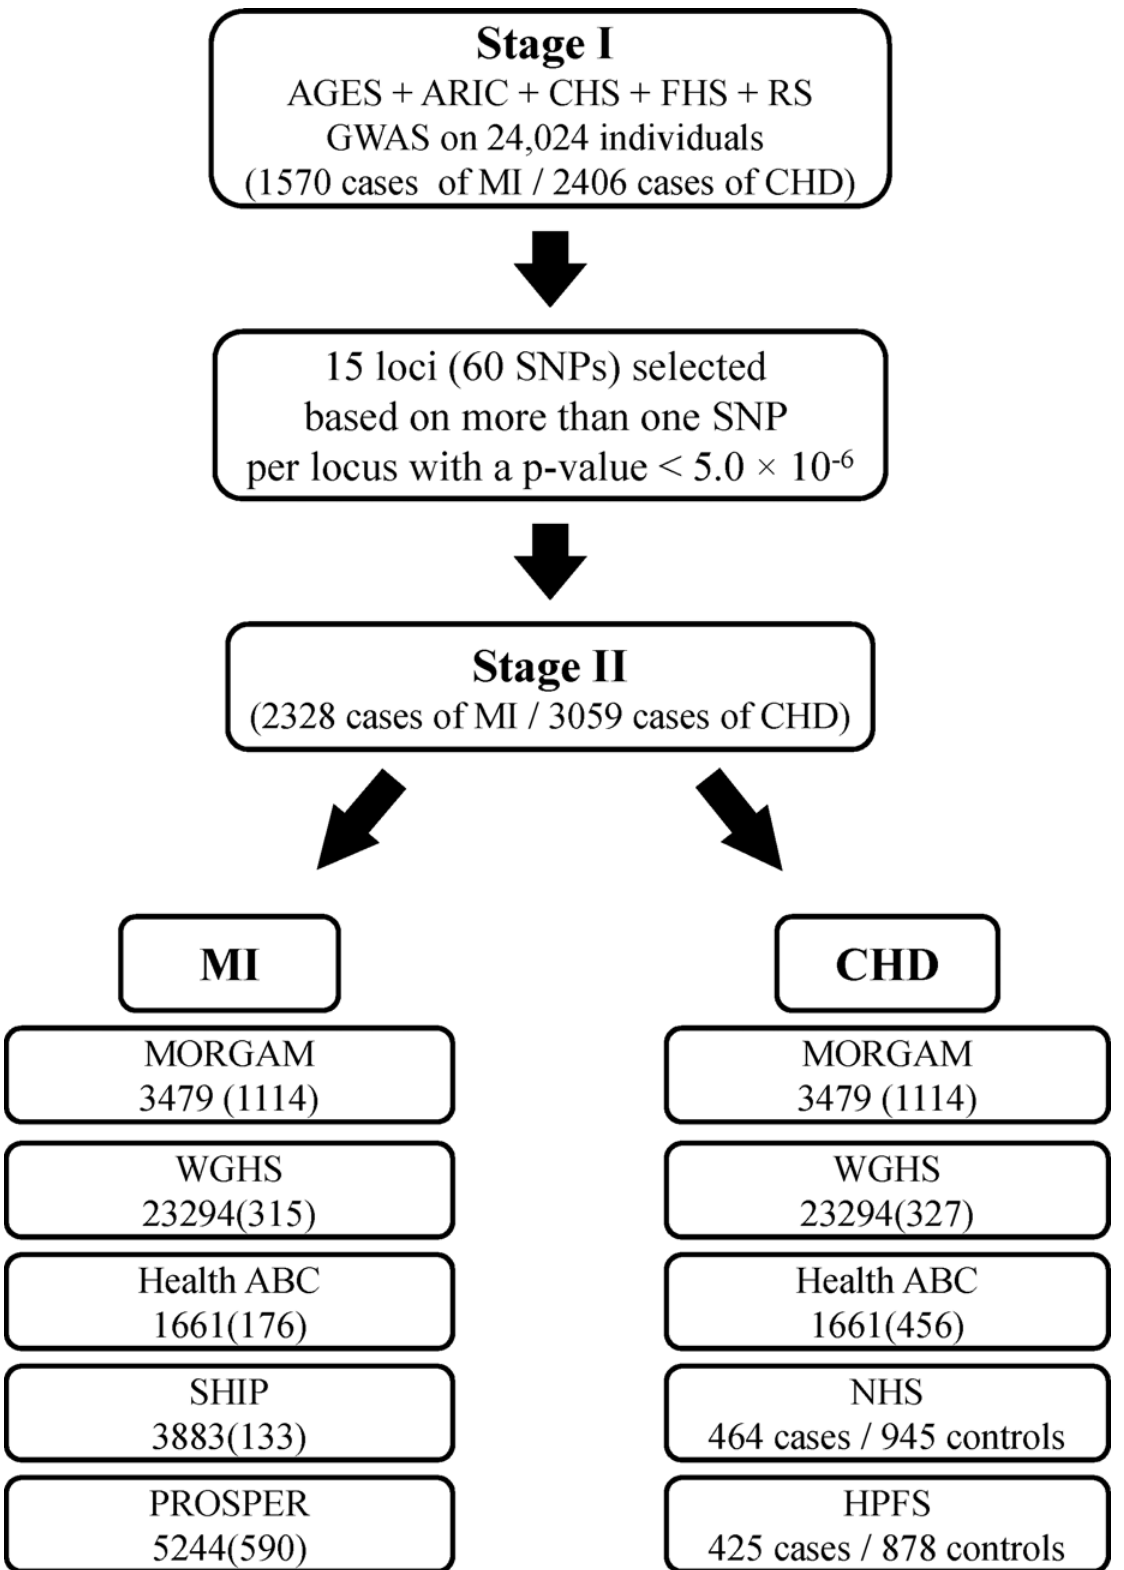
Fig 1. Study design for identification and validation of SNPs associated with MI and CHD. doi:10.1371/journal.pone.0144997.g001 PLOS ONE | DOI:10.1371/journal.pone.0144997 March 7,